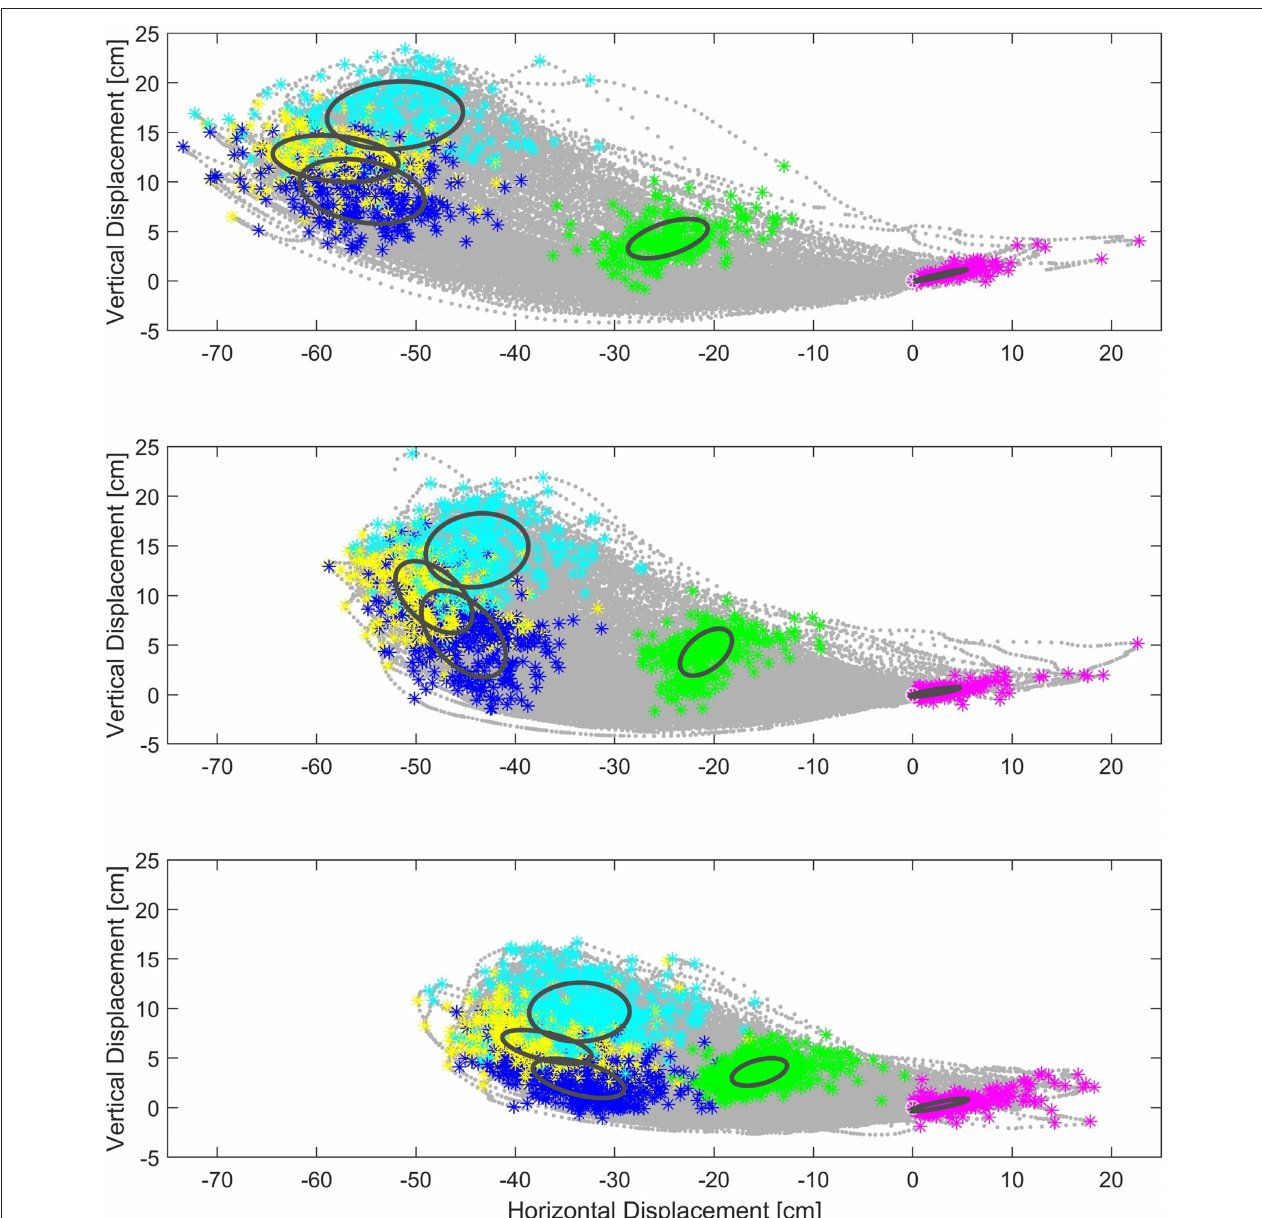
FIGURE 8 | In the background, actual captured ankle position data point in the sagittal plane, all from subject gait cycles. Same Key events for all subjects are shown in color clusters. Centroids and ellipses represent average data and maximum and minimum variance per test. Top: Key events of 60[ cm ], Middle: Key events of 45[ cm ], Bottom: Key events of 30[ cm